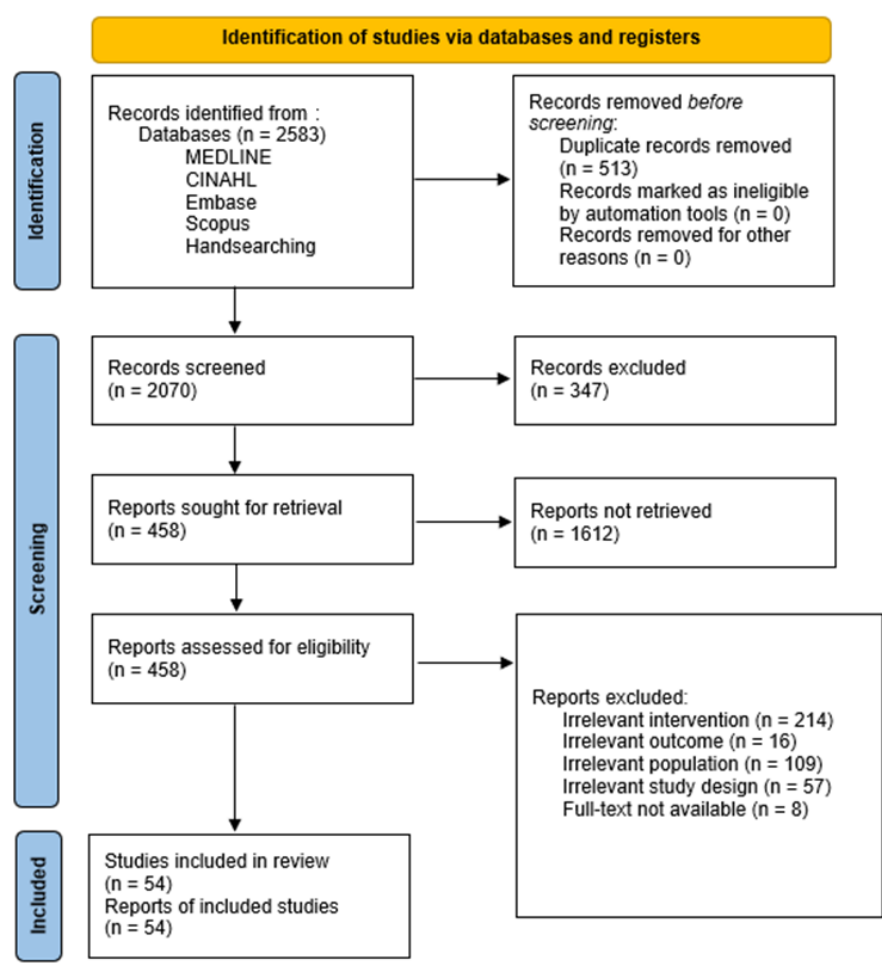
Figure 1. Flow chart diagram of included studies.